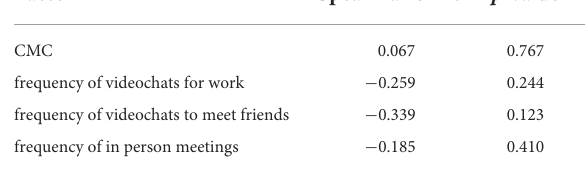
TABLE 5 Spearman’s correlations r (20) with Digital Commensality items mean